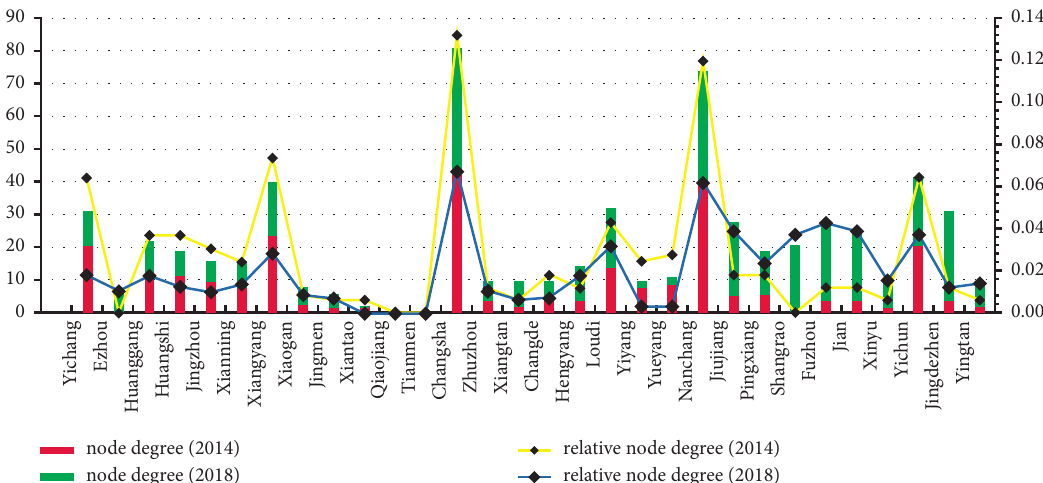
Figure 1: The changes to the city node degree. (Notes: the value of Wuhan is so large that it affects the scale of the picture, so data for Wuhan are not